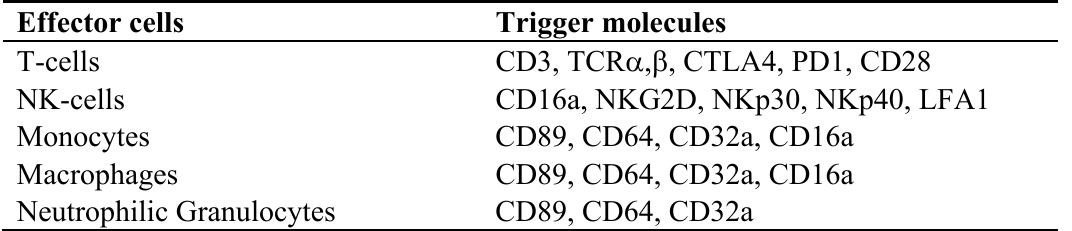
Table 1. Trigger molecules on different populations of effector